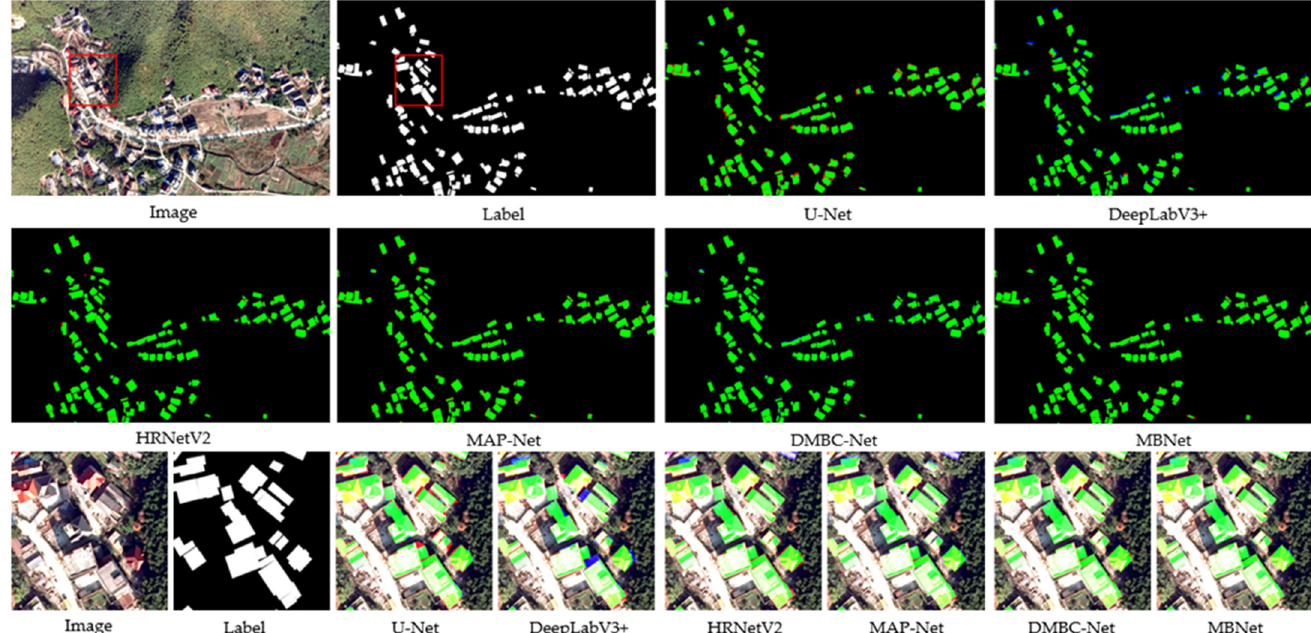
Figure 7. Segmentation results of the different SOTA methods on the mountain landform scene 2 test dataset. The bottom row is a close-up view of the red box.